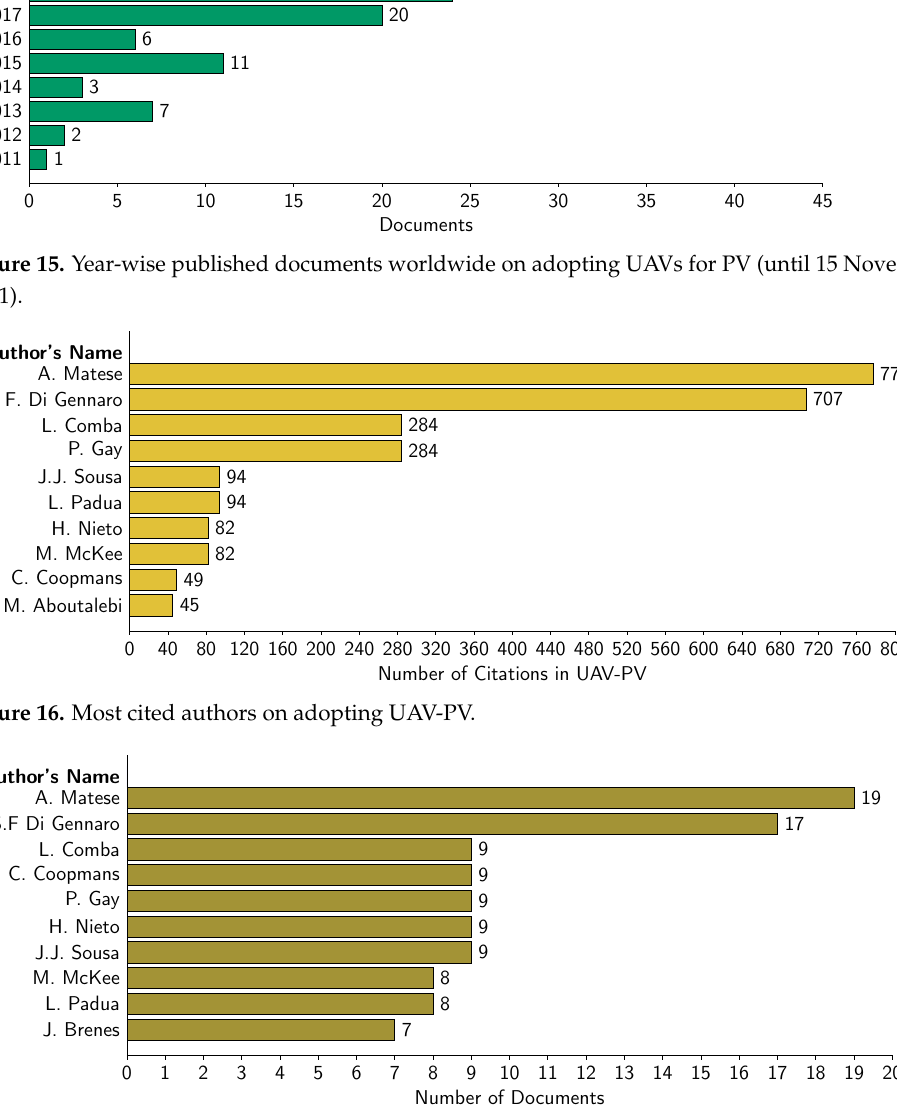
Figure 17. Most documents published by an author on adopting